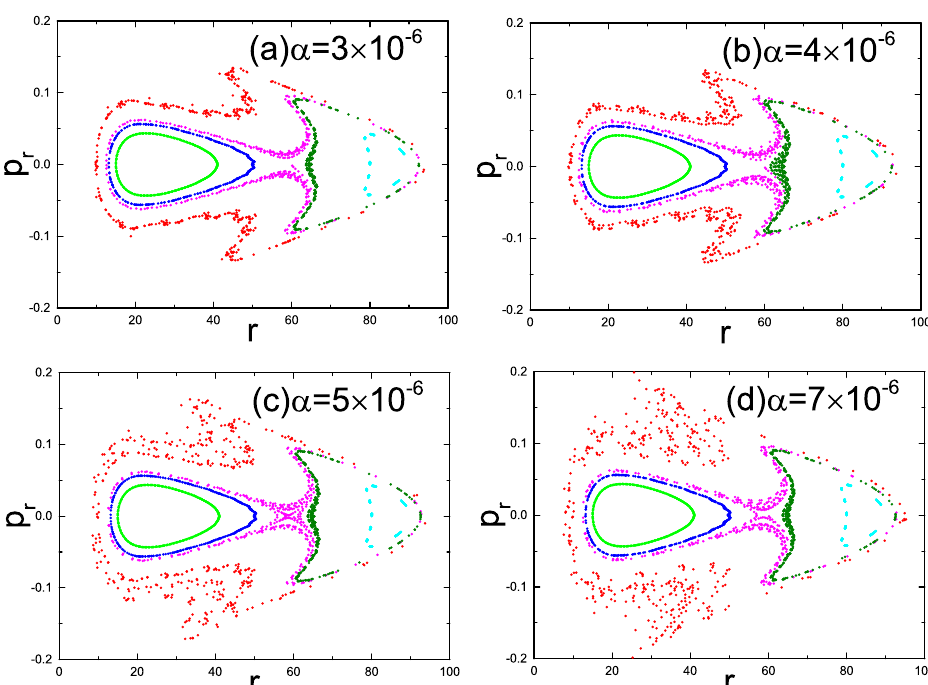
Figure 3. Dependence of the orbital dynamics on the cosmological parameter α . Poincaré sections with the same parameters E = 0.9900, L = 3.7, b = 0.0012, β = 0, and different values of cosmological parameter α are given. The orbits are r =